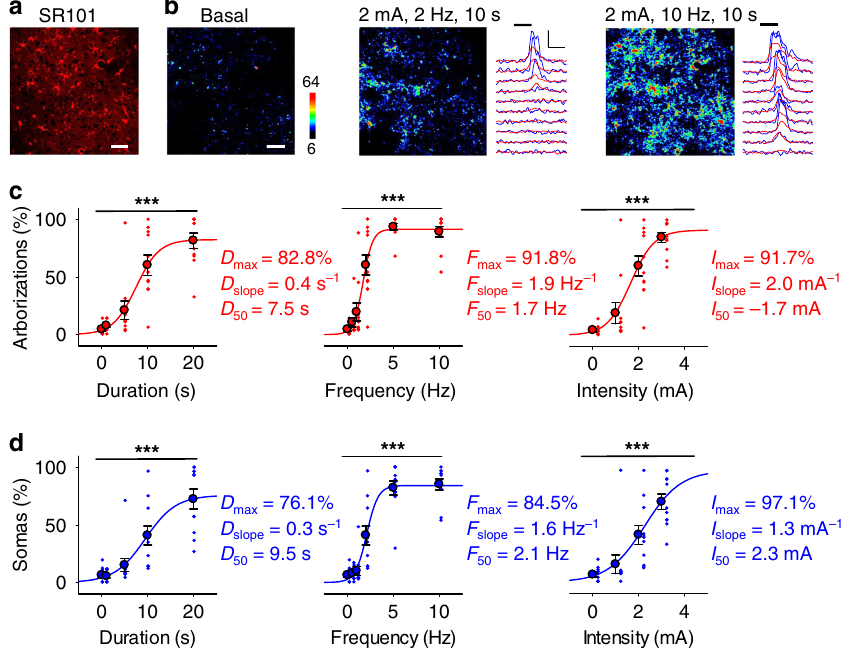
Fig. 2 Astrocyte population responses are stimulus dependent. a SR101 staining. Scale bar = 50 µ m. b Pseudocolor Ca 2 + images with Ca 2 + traces of arborizations (red) and somas (blue) before (basal) and during sensory stimulation with indicated parameters. Scale bar = 50 µ m. Scale = Δ F , 10s. Horizontal black bars indicate sensory stimuli. c Arborization responses vs. stimulus duration ( D ), frequency ( F ) and intensity ( I ), (1-way ANOVAs: duration: p = 4.7e − 13 ; frequency: p = 5.3e − 23 ; intensity: p = 2.0e − 10 ; n = 11 imaging planes, 4 mice). Data were fi t to the sigmoid function in Eq. (1) (see Methods section), where D F I max , max , and max were the maximum responses for the respective stimulus parameter; considered as indicative of the astrocyte discrimination of the sensory stimuli, i.e., how the astrocyte activity response changes as the stimulus changes; and D F I 50 , 50 , and 50 were the stimulus parameter values at which astrocyte responses were 50% of the maximum values, which was considered as indicative of astrocyte sensitivity of sensory stimuli. d as in c , but for somas (1-way ANOVAs: duration: p = 1.0e − 10 ; frequency: p = 3.3e − 21 ; intensity: p = 1.6e − 7 ; n = 11 imaging planes, 4 mice). Means ±SEM, ‘ *** ’ : p <0.001, 1-way ANOVA. Representative images and traces are in line with independent experiments carried out in 4 mice. Source data are provided as a Source Data fi